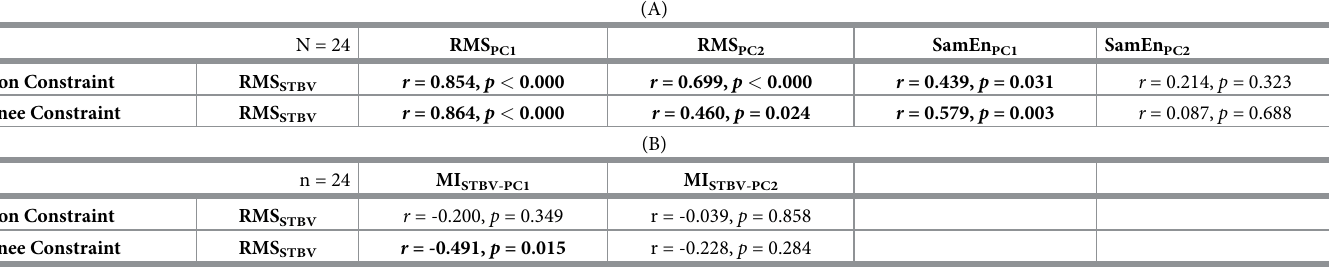
Table 5. Correlation between the amount of stabilometer angular velocity (RMS STBV ) and key PC variables for the non-constraint and knee constraint conditions. (A). Correlation between RMS STBV and PC size and complexity, (B). Correlation between RMS STBV and PC-STBV coupling (MI STBV-PCS ). (A)